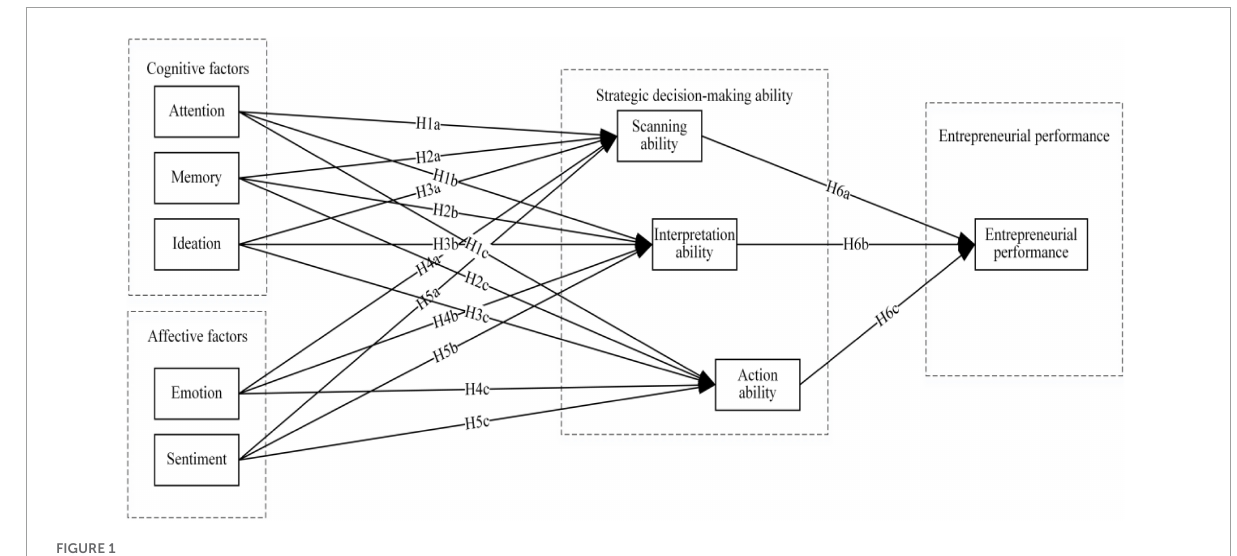
FIGURE1 Conceptual